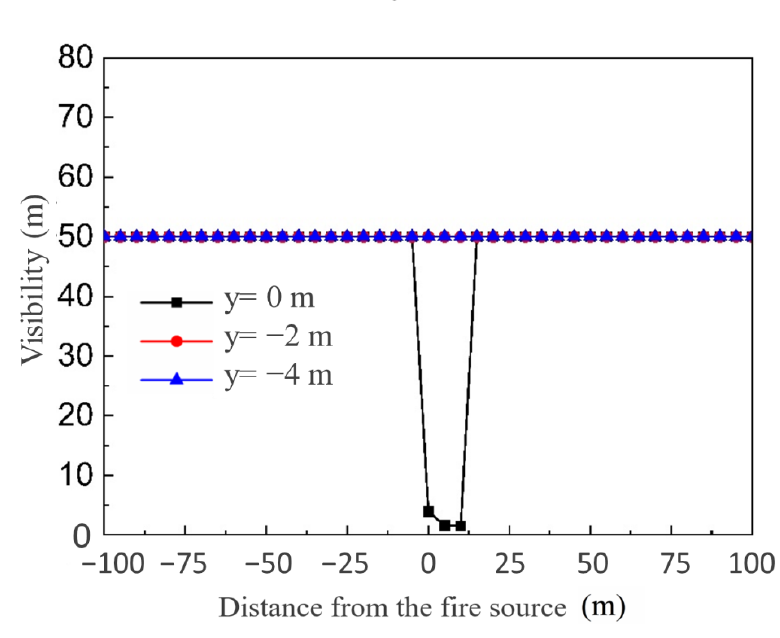
Figure 16. CO distribution at 1.8 m height.